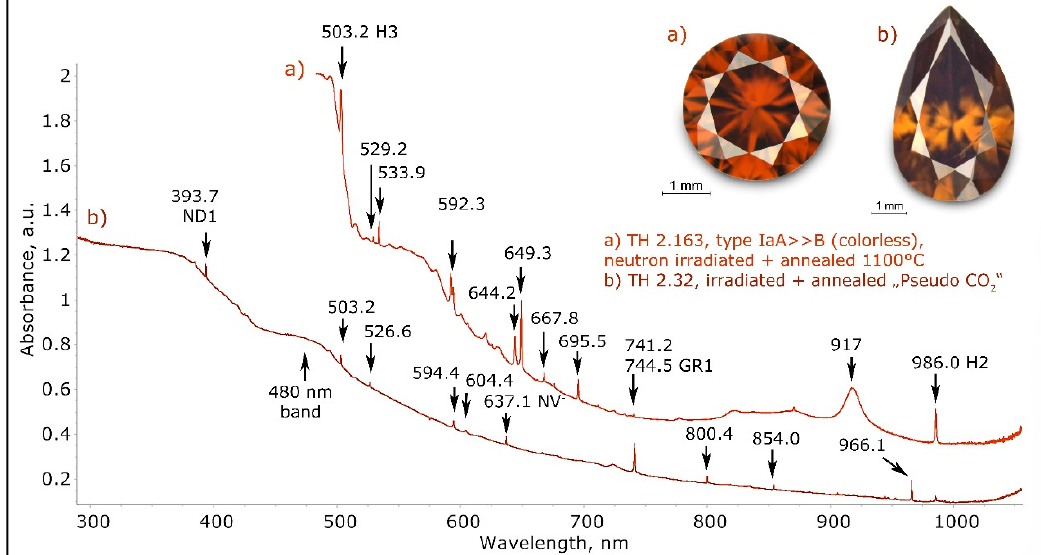
Figure 29. The low temperature UV-Vis-NIR spectra of two type I brown diamonds with artificial irradiation-related color are shown in this graph. Trace ( a ) shows the spectrum of a colorless diamond that has been exposed to a large dose of mostly fast neutron irradiation, which turned the stone opaque black; the stone was then heated to 1100 °C for 3 h, which resulted in this deep orange brown color. The strong absorption continuum is the result of the large accumulation of vacancies-cluster-like defects induced by irradiation which—unlike the single vacancies that induce GR1 and ND1— are stable to rather high temperatures. Trace ( b ) shows what happens when a brown Pseudo-CO 2 diamond is irradiated by electrons and heated to 700 °C—it will be mostly brown again after the treatment. Such diamonds are not suitable for any treatment, the results are never satisfactory, as basically such stones are unaffected color-wise. The spectra have been shifted vertically for clarity.